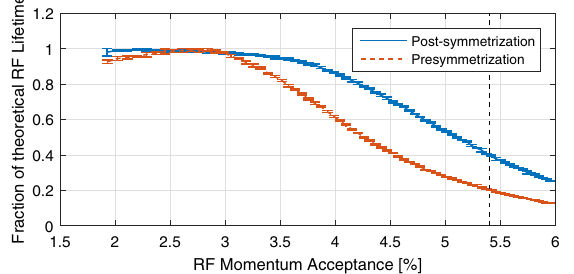
FIG. 16. Measured lifetime plotted against rf momentum acceptance as a ratio of measured lifetime to simulated lifetime only determined by the rf-acceptance. Both the measured and simulated lifetimes were normalized against their maxima before taking the ratio. The vertical dashed line corresponds to the rf momentum acceptance of the MAX IV 3 GeV ring during delivery. At this acceptance value the symmetrization increased the Touschek lifetime by a factor of 2.